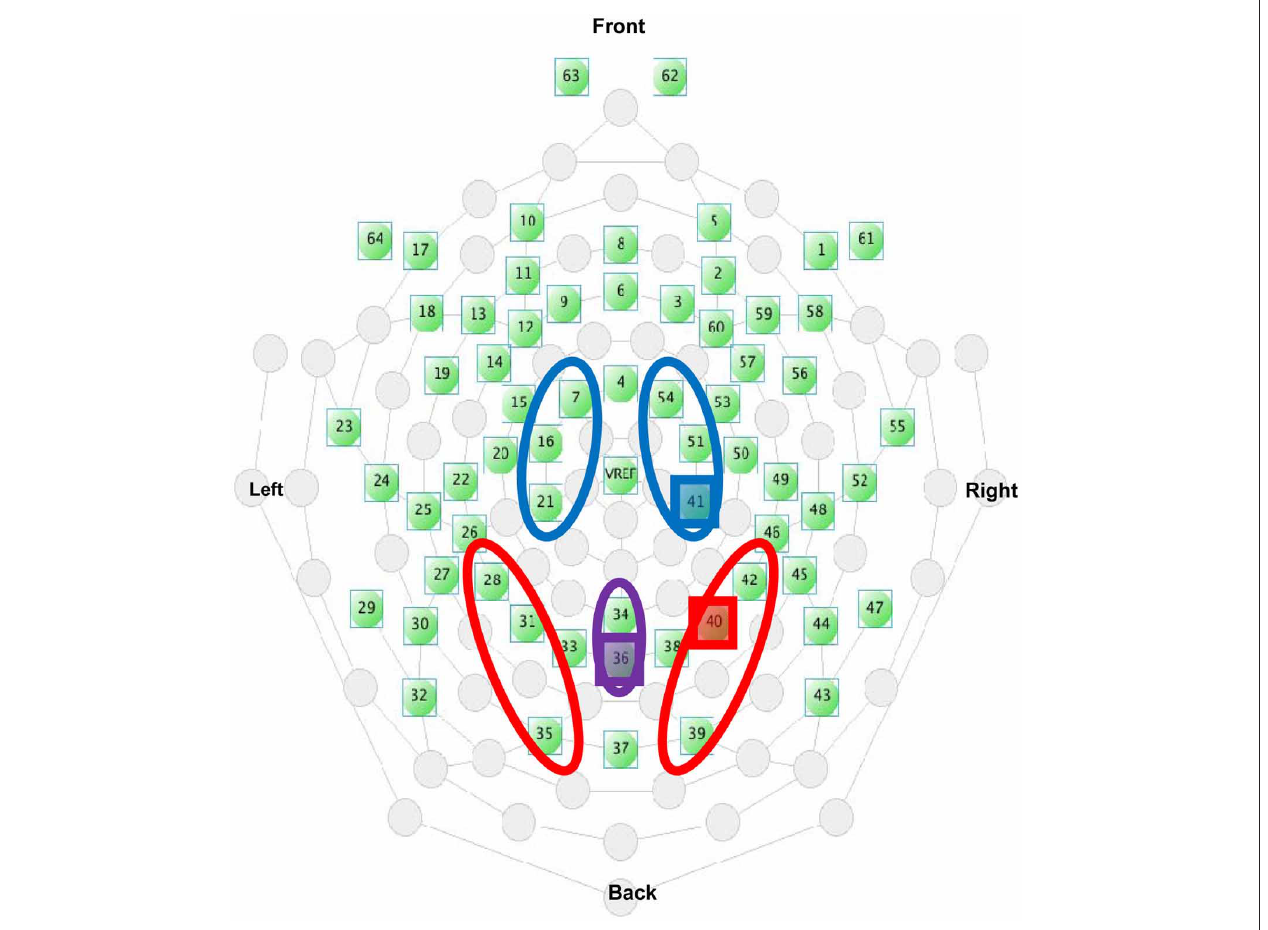
FIGURE 4 | Electrode selection from the EGI 64-channel Hydrocel net. The highlighted electrodes indicate the placement of the representative electrodes used in Figures 5B , 6B , and 9